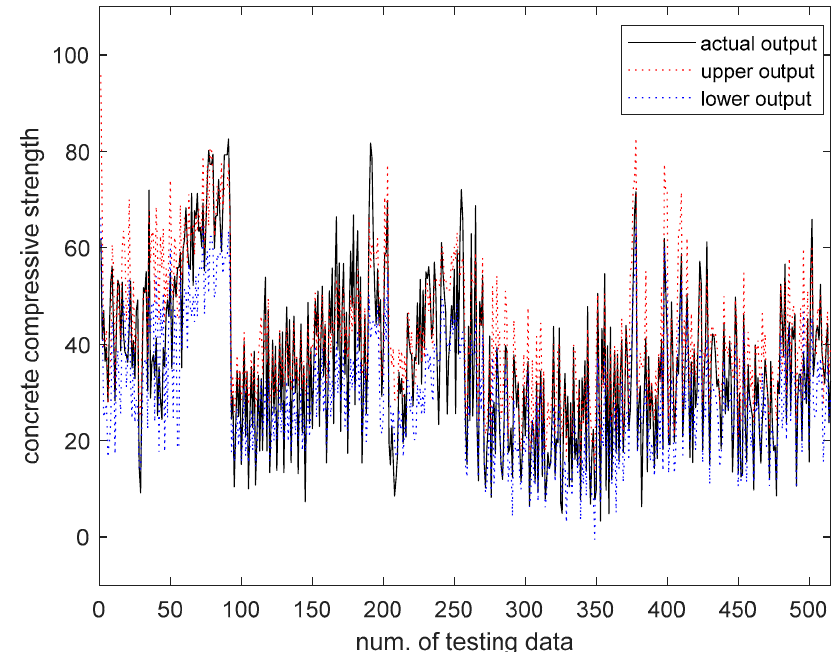
Appl. Sci. 2020 , 10 , x FOR PEER REVIEW Figure 12. Prediction results for interval-based IGM (Case2). Figure 12. Prediction results for interval-based IGM (Case2).